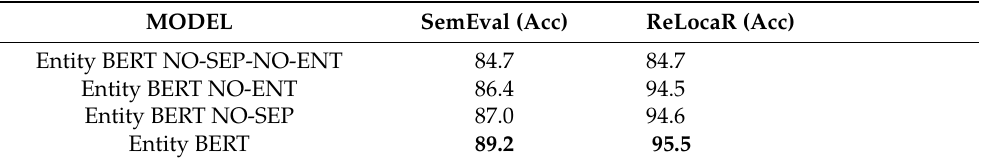
Table 3. Ablation analysis on two datasets: ReLocaR and